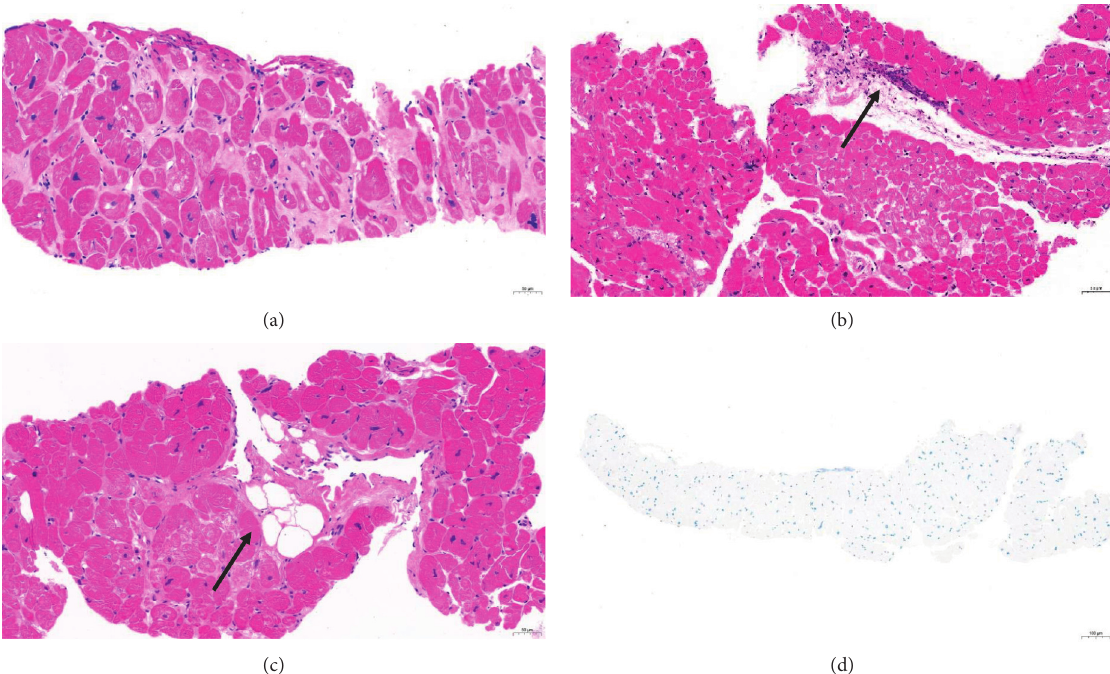
Figure 4: Histopathology changes in HOCM specimens. (a) Myocytes hypertrophy and hyperchromatic nuclei with bizarre shapes. (b) Inflammatory cells infiltration. (c) Adipocyte infiltration. (d) No amyloidosis (H-E staining and Congo red staining